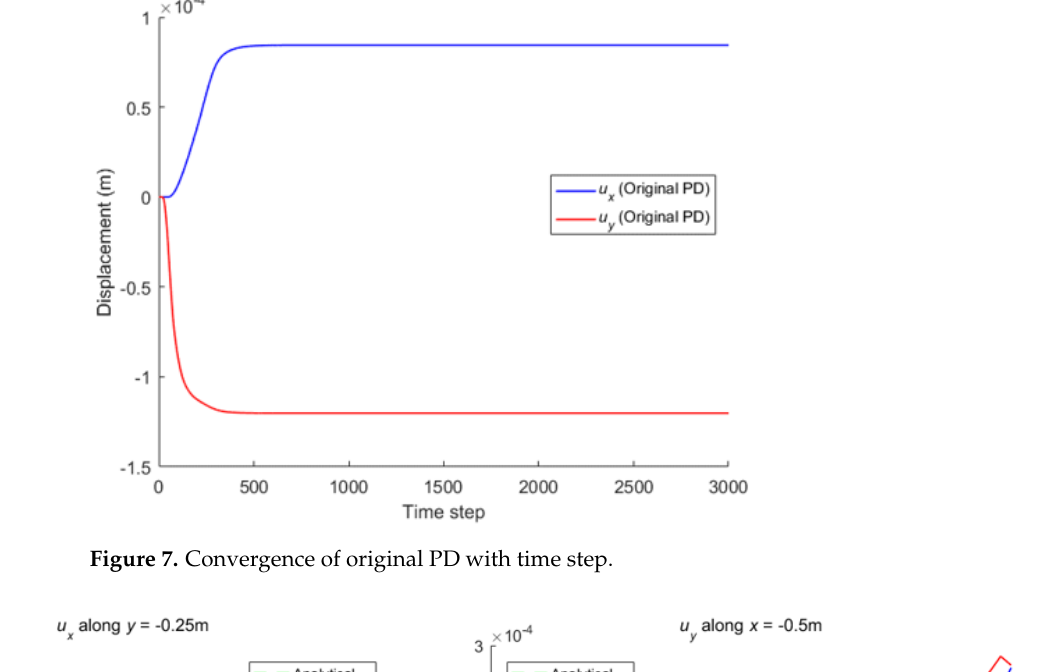
( b ) Figure 6. The displacements along central lines of the rectangular plate for three different combina- tions: ( a ) u x along y = 0; ( b ) u y along x = 0. Figure 5 that the calculation converges very quickly with time step, no matter which combination mode is adopted. From Figure 6, we see that the numerical results of the three different combinations agree with each other, and the errors between them and clas- sical solutions are all within 5%. Therefore, the numerical algorithm is of m - convergence [41 – 44]. Comparison between Equation (7) and the original PD is carried out through numer-